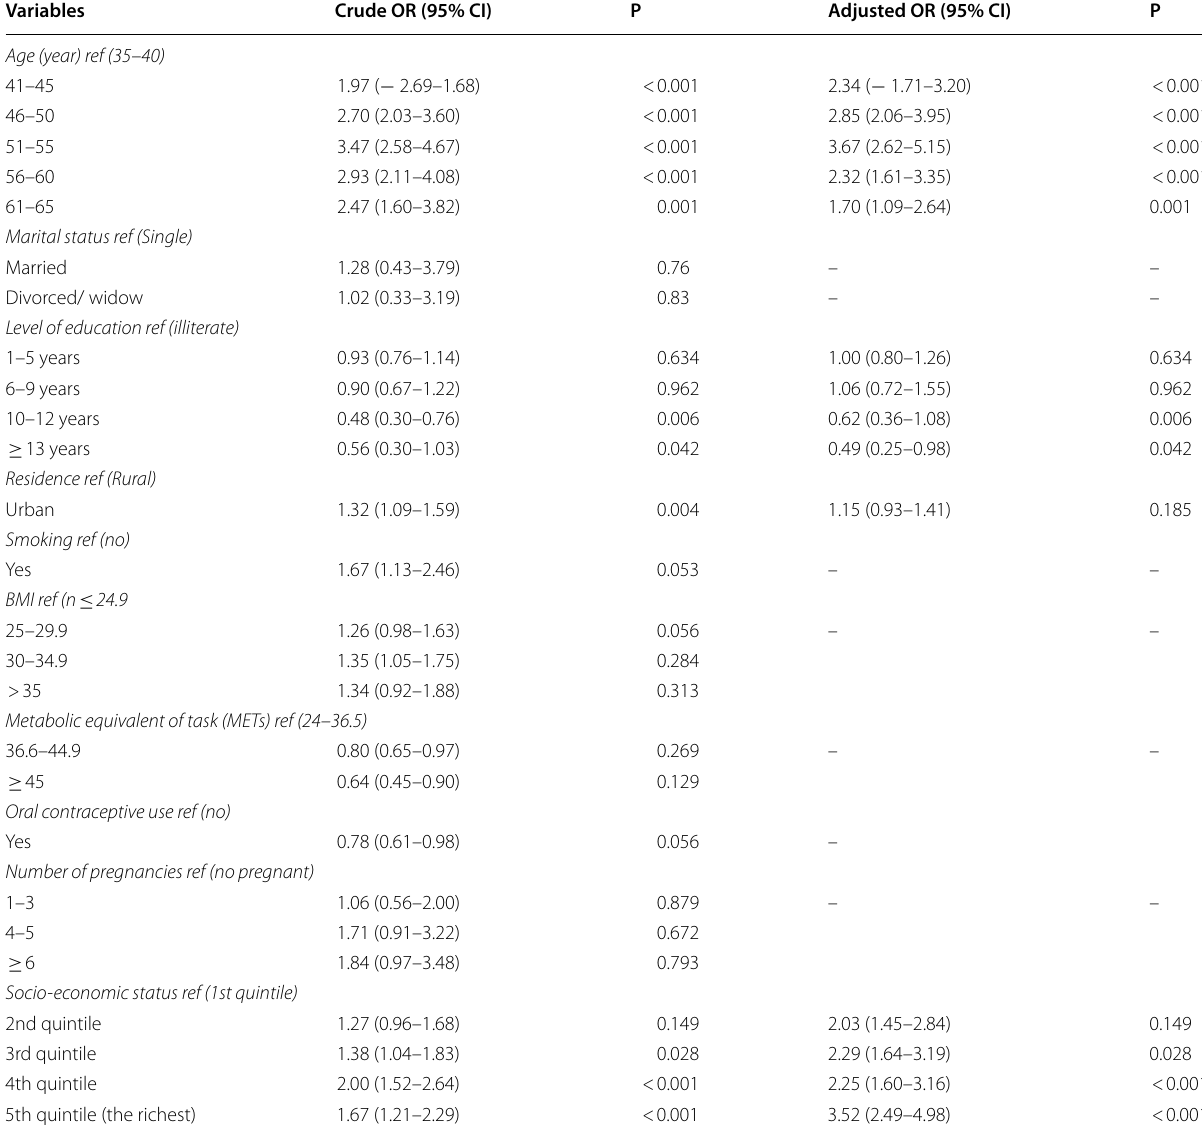
Table 2 Associated factors for mammography uptake